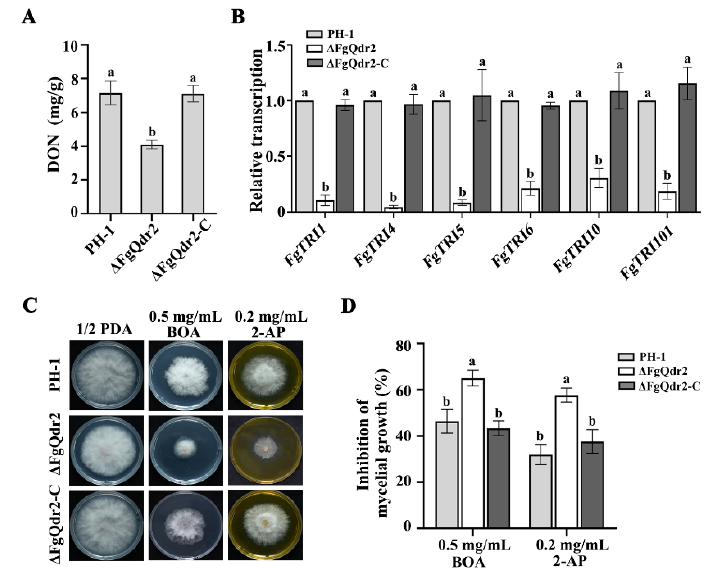
Figure 5. FgQdr2 is required for DON production and phytoalexin extrusion in F. graminearum . ( A ) DON content determination of each strain. ∆ FgQdr2 showed significant deficiency in DON biosynthesis. ( B ) The gene expression level of FgTRI genes in each strain. The expression level of each FgTRI in PH-1 in TBI with putrescine was referred to as 1, and the FgACTIN gene was used as the internal control for normalization. ( C ) Sensitivity of each strain to phytoalexin BOA and 2-AP. ∆ FgQdr2 showed increased sensitivity towards the two phytoalexins shown above. ( D ) Hyphal growth inhibition rate under with the above phytoalexins. In ( A ), ( B ), and ( C ), mean and standard deviation were estimated with data from three independent biological replicates (n = 3). Different letters indicate significant differences based on ANOVA analysis, followed by Turkey’s multiple comparisons test ( p < 0.05).